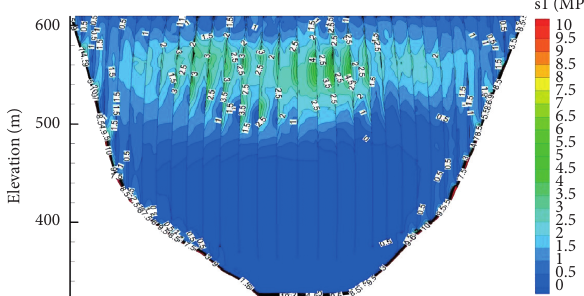
Figure 25: Envelope of maximum principal tensile stress distri- bution of downstream surface of the dam for relative sliding condition.